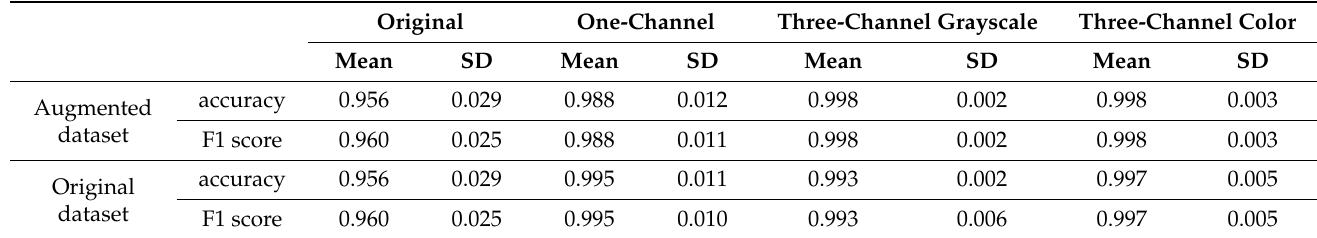
Table 9. Average and standard deviation of Resnet18 validation